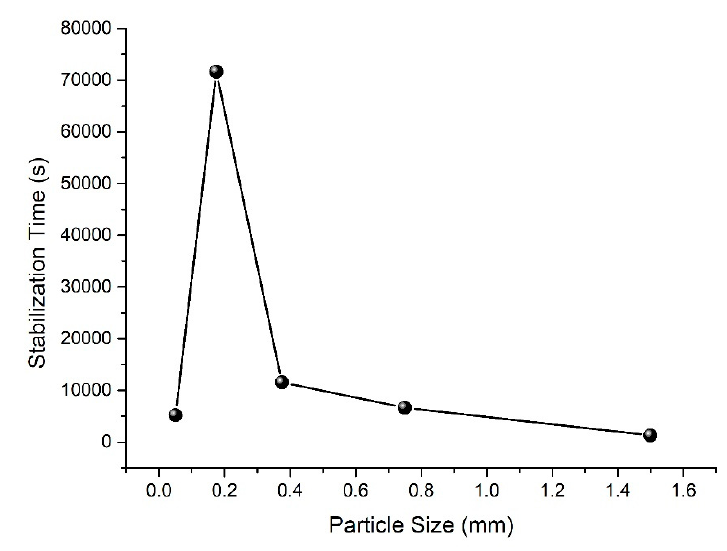
Figure 14. Varying amounts of time required to reach the limiting concentration.